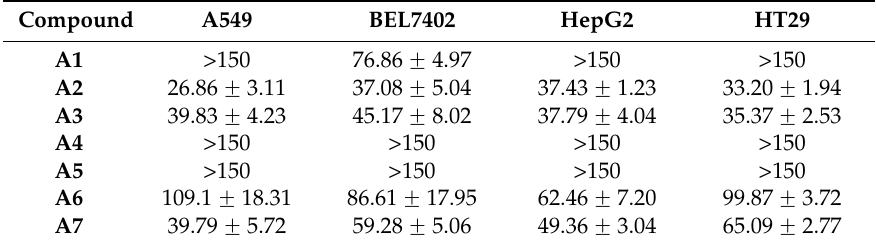
Table 3. IC 50 ( µ g/mL) of various dihydrochalcones on cancer